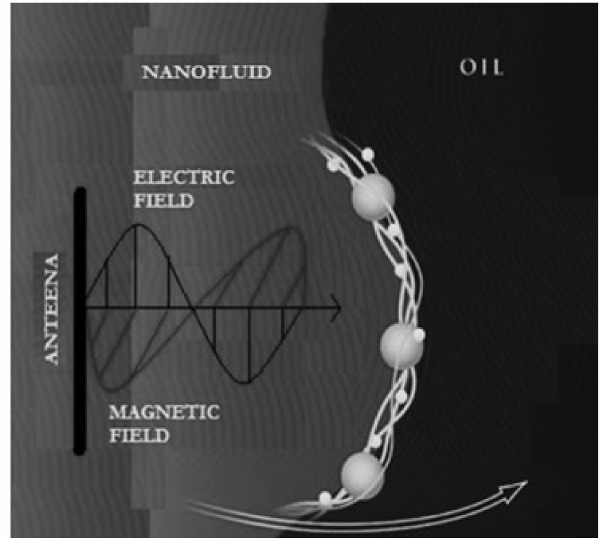
Figure 10. Disturbance at oil/water interface when EM waves were applied in the presence of dielectric nanofluids. Source: M. Adil, et al. [60] reprinted with